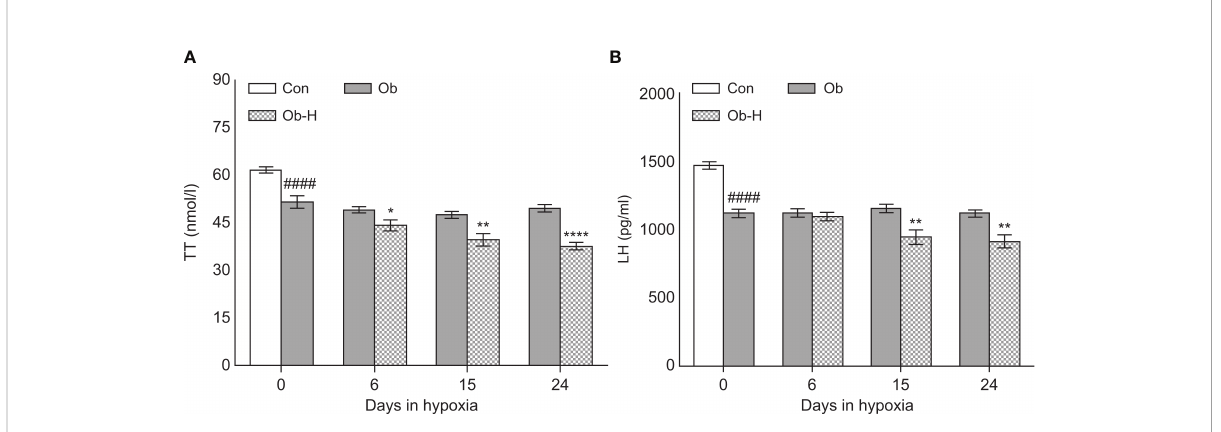
FIGURE 5 Chronic high-altitude hypoxia exposure decreased TT levels in obese male mice. (A) serum TT concentration, (B) serum LH concentration. Data are represented as mean ± SEM. (A, B) : n = 12 – 22, #### P < 0.0001 vs Con; * P < 0.05 vs Ob, ** P < 0.01 vs Ob, **** P < 0.0001 vs Ob. Con, Control group; Ob, Obese group; Ob-H, Obese-Hypoxia